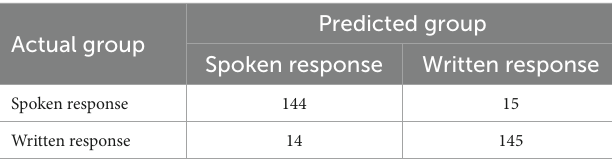
TABLE 4 Confusion matrix for classifying writing and speaking in the training